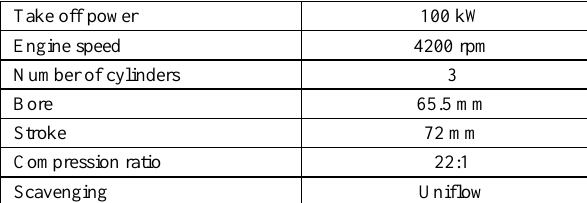
Table 2. Basic parameters of the research object